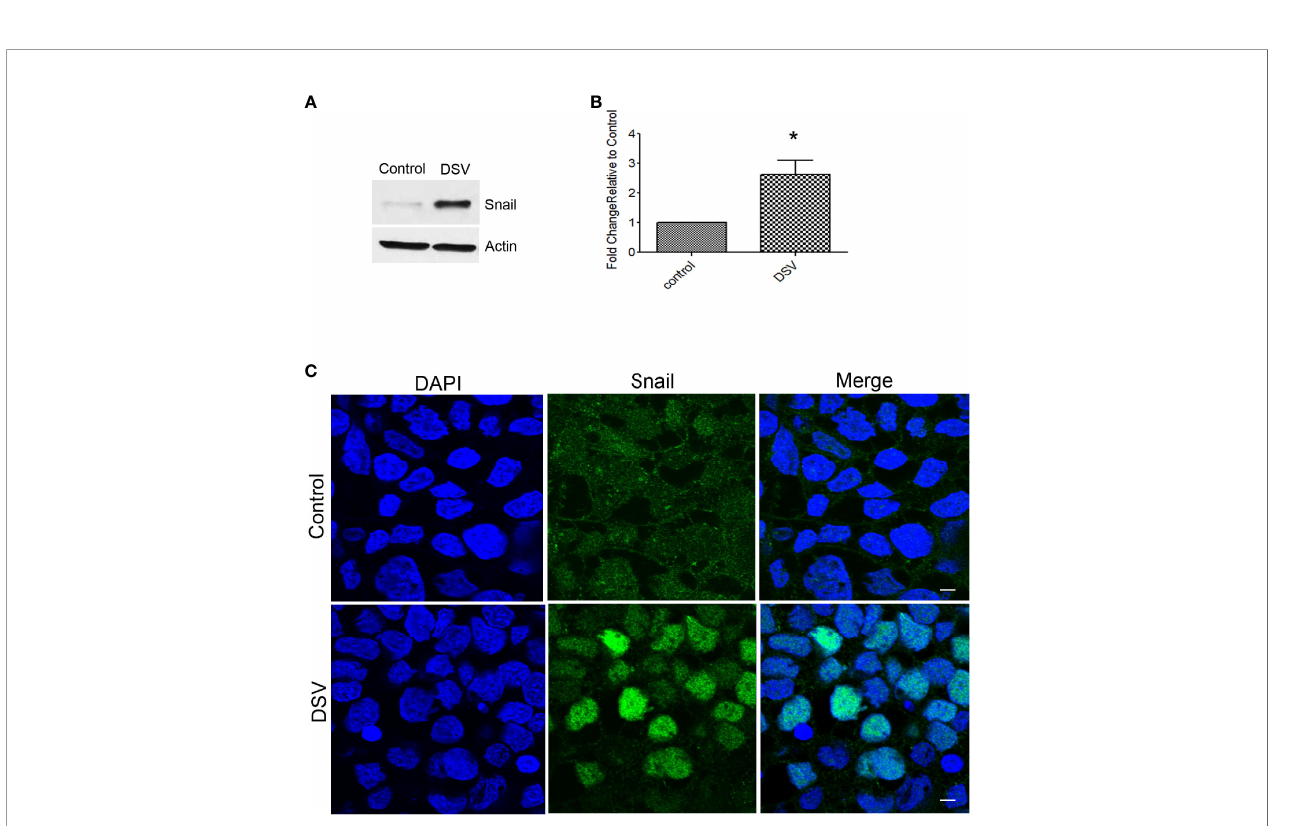
FIGURE 3 | DSV induced snail protein expression. Polarized cells were treated with DSV (MOI 20) for 24 hours. (A, B) snail detection by Western blot in Control and DSV-treated cells. Actin was used a loading control. Graph represents Mean ± SEM from at least 3 independent experiments. *p<0.05. (C) Immuno fl uorescence of cells infected with or without DSV. Cells were fi xed with 4% paraformaldehyde and stained with anti-snail antibody followed by secondary antibody labeled with Alexa Flour – 488. Cells were visualized with Olympus Fluoview FV1200 confocal microscope. Scale bar=20 µm.